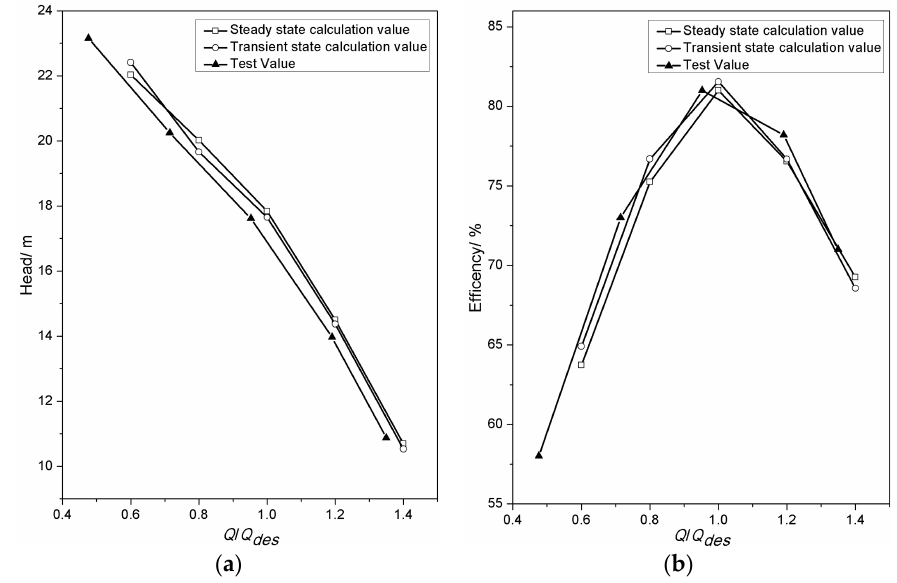
Figure 5. Comparison between the simulated and experimental results: ( a ) flow-head curve ( Q ~ H ); ( b ) flow-efficiency curve ( Q ~ η ).